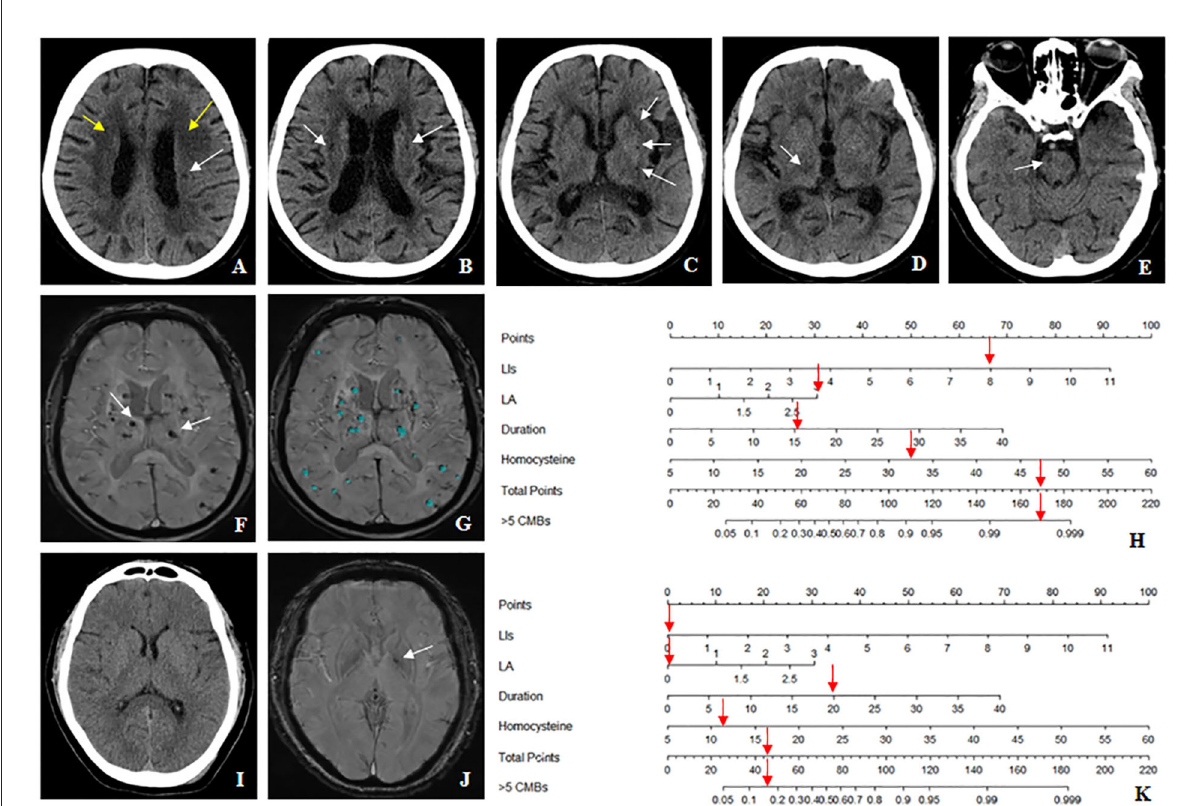
FIGURE8 The nomogram accurately differentiates > 5 cerebral microbleeds (CMBs) with ≤ 5 CMBs in the hypertensive population. (A–H) Case 1: a 64-years-old female with hypertension for 15 years, whose homocysteine level was 32.9 µ mol/L. (A) The Blennow score of the LA was 3 (yellow arrow). (A–E) The number of LIs defined by CT was 8 located in the left basal ganglia, right thalamus, bilateral semiovale center, and brainstem region (white arrow). (F,G) susceptibility-weighted imaging (SWI) shows multiple CMBs ( > 5) (white arrow), which were diagnosed by BioMind AI software (green marker). (H) According to the combined model, the prediction probability of > 5 CMBs was more than 99% (red arrow). (I–K) Case2: a 54-years-old male with hypertension for 20 years, whose homocysteine level was 11.1 µ mol/L. (I) Both the Blennow score of the LA and the number of LIs were 0. (J) Only one CMB was seen in the left basal ganglia region (white arrow), which met the diagnostic criteria of ≤ 5 CMBs. (K) According to the combined model, the prediction probability of > 5 CMBs was between 10 and 20% (red